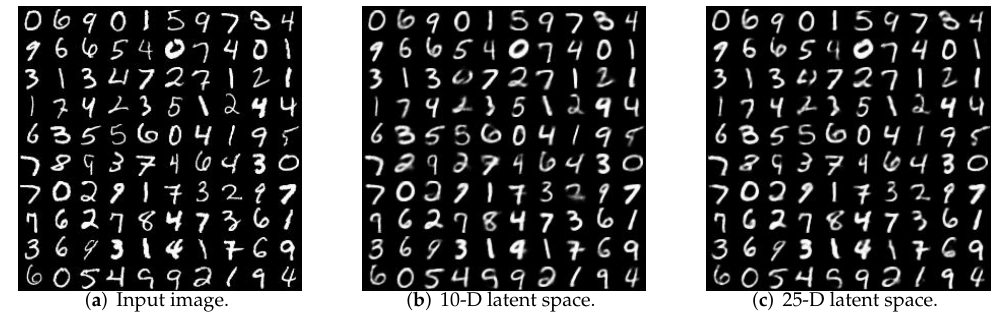
Figure 4. Reconstruction quality for different dimensionalities.